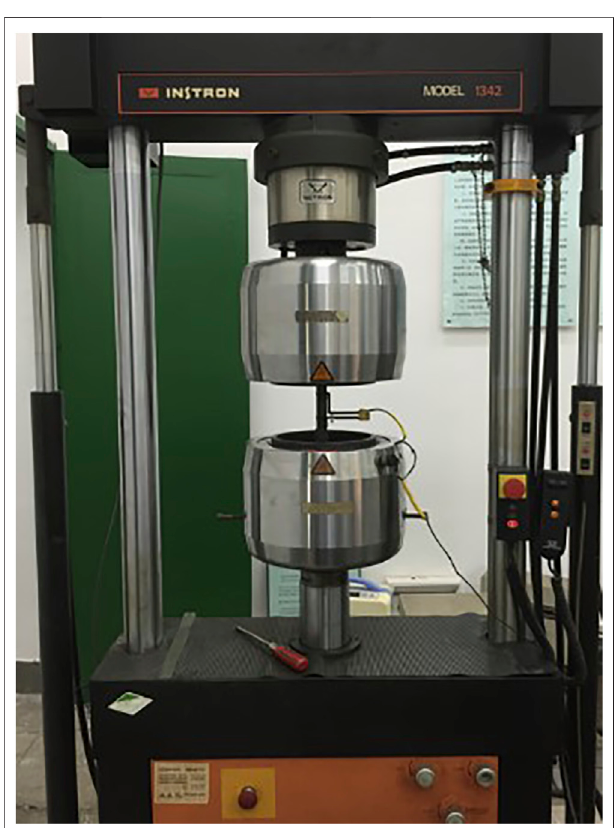
FIGURE 8 | Steel plate performance testing.